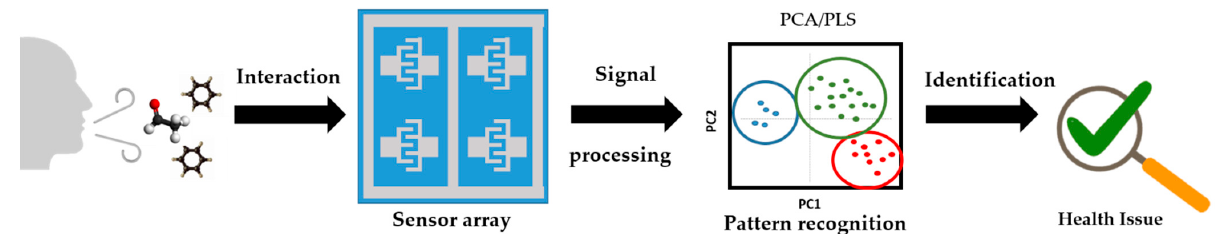
Figure 1. Scheme of the process to improve the selectivity issue. Biomarkers from human breath samples interact with different sensitive layers of the sensor array. Response features are treated by a dimensionality reduction or clustering step (e.g., principal component analysis, PCA) and a classification or regression step (e.g., partial least squares, PLS) may be used for identifying the presence of certain gas compounds associated with health problems.